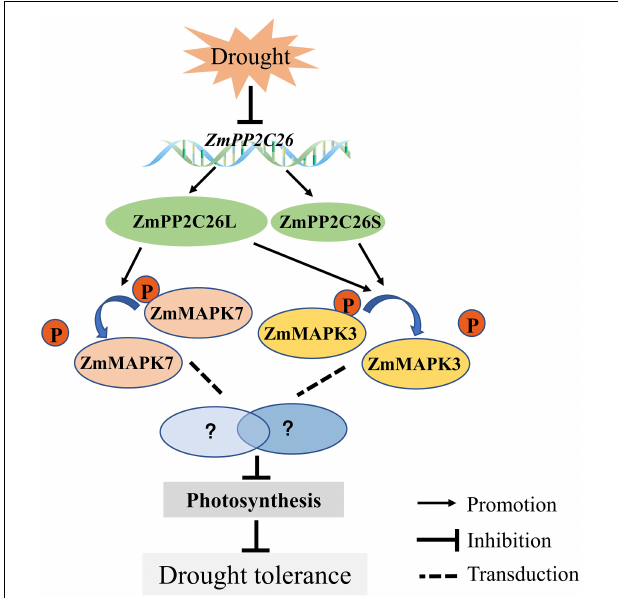
FIGURE 9 | The proposed model depicting ZmPP2C26 alternative splice variants negatively regulate drought